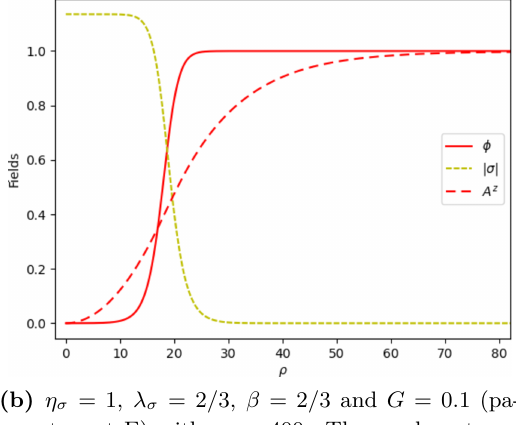
p λ φ λ σ (left) and those with β > 1 2